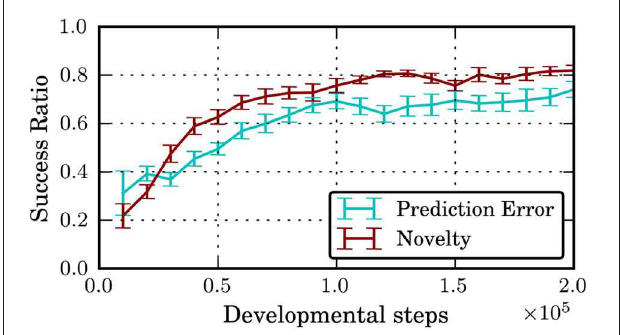
Frontiers in Neurorobotics